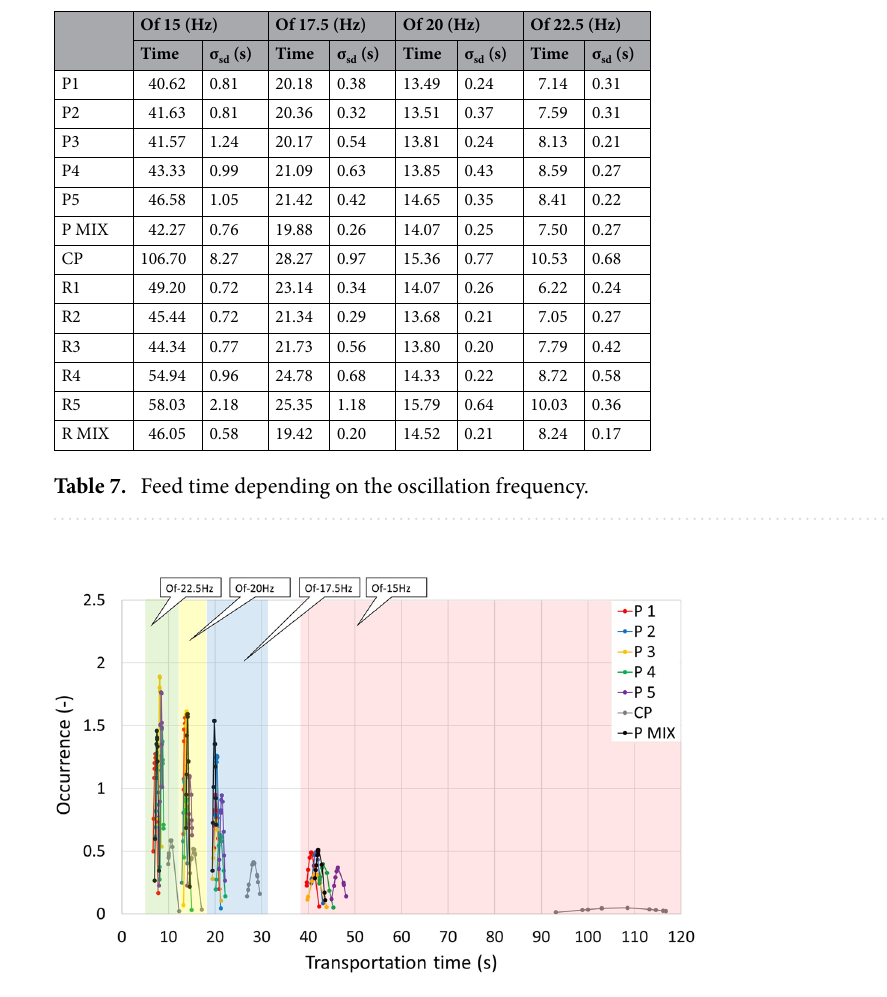
Figure 21. Transport time of particles when transporting pellets and crushed pellets, depending on the different frequencies of the transport distance.